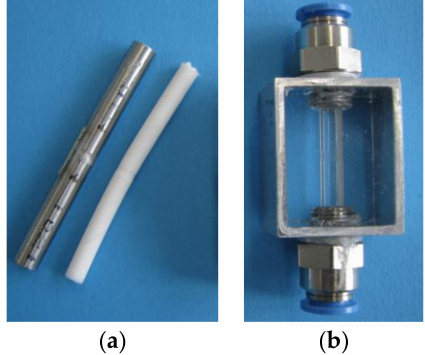
Figure 4. ( a ) Welded tube and silicone core made of Elastosil ® M 4601; ( b ) silicone replication made of Elastosil ® RT 601 inside the aluminum frame with fluidic connections for µ -PIV analysis.